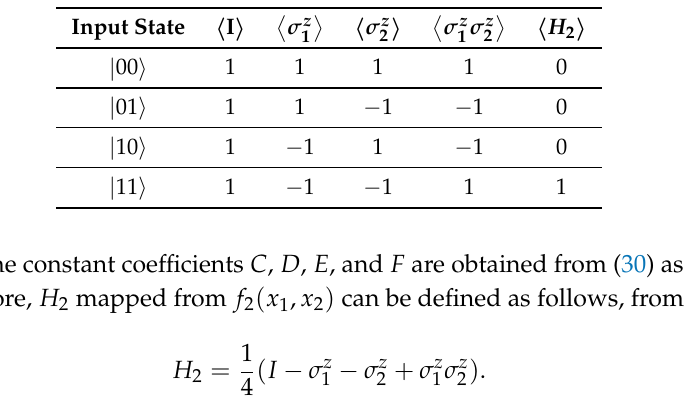
Table 2. 2-qubit mapping table to obtain H 2 mapped from f 2 ( x 1 , x 2 )